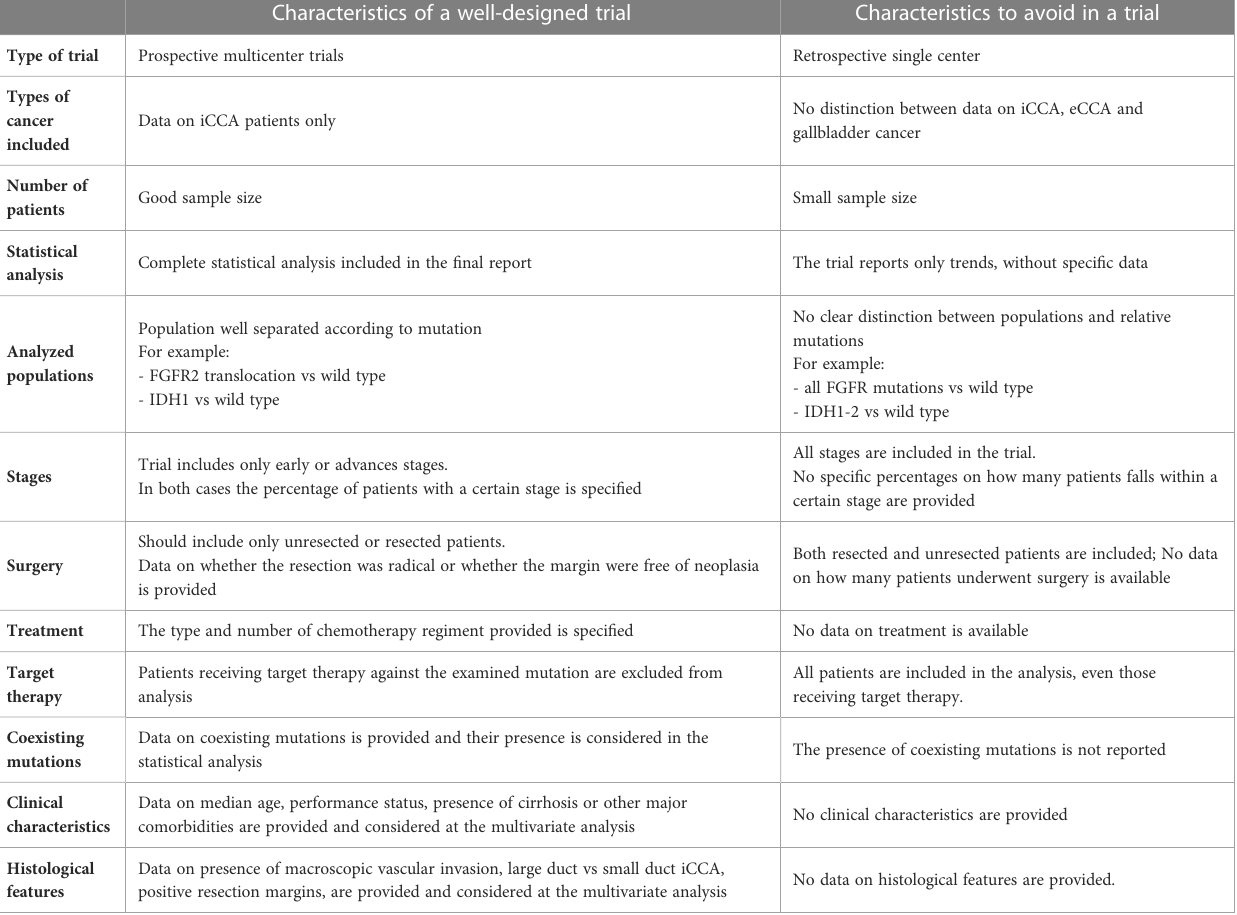
TABLE 5 “ Ideal ” parameters to be included in a trial aimed at de fi ning the prognostic role of FGFR or IDH mutations in iCCA. Characteristics of a well-designed